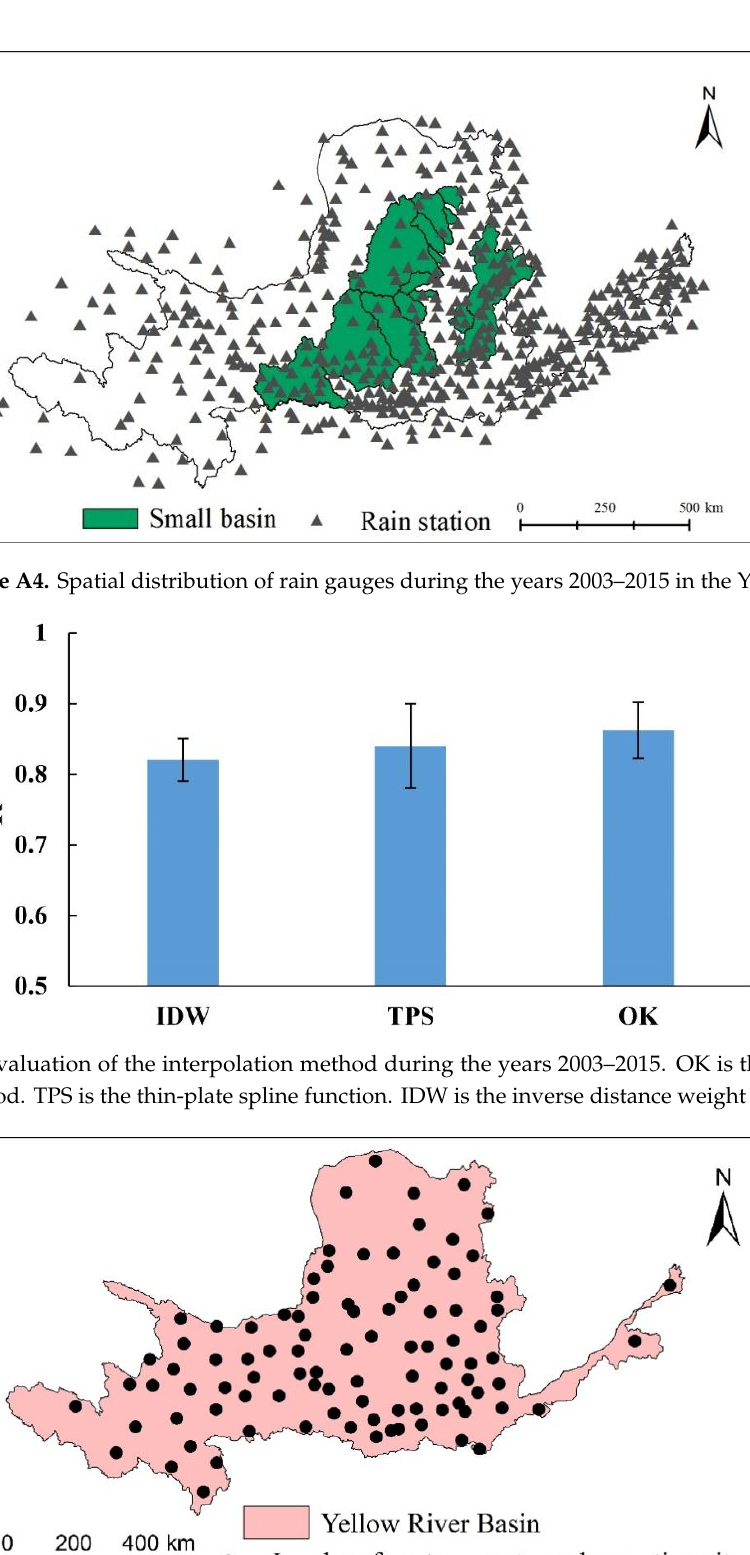
Figure A6. The spatial distribution of the land surface temperature observation sites during the years 2003–2015.